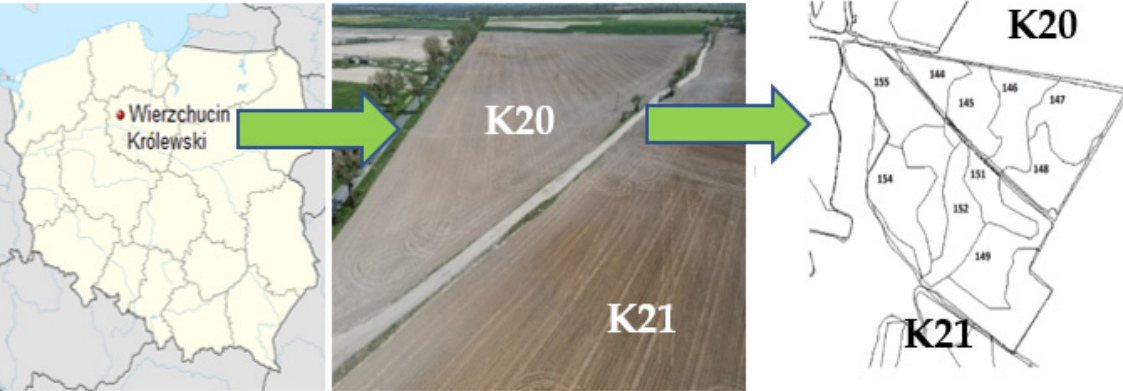
Figure 1. Location of the study area with a photograph of the two studied fields and separated